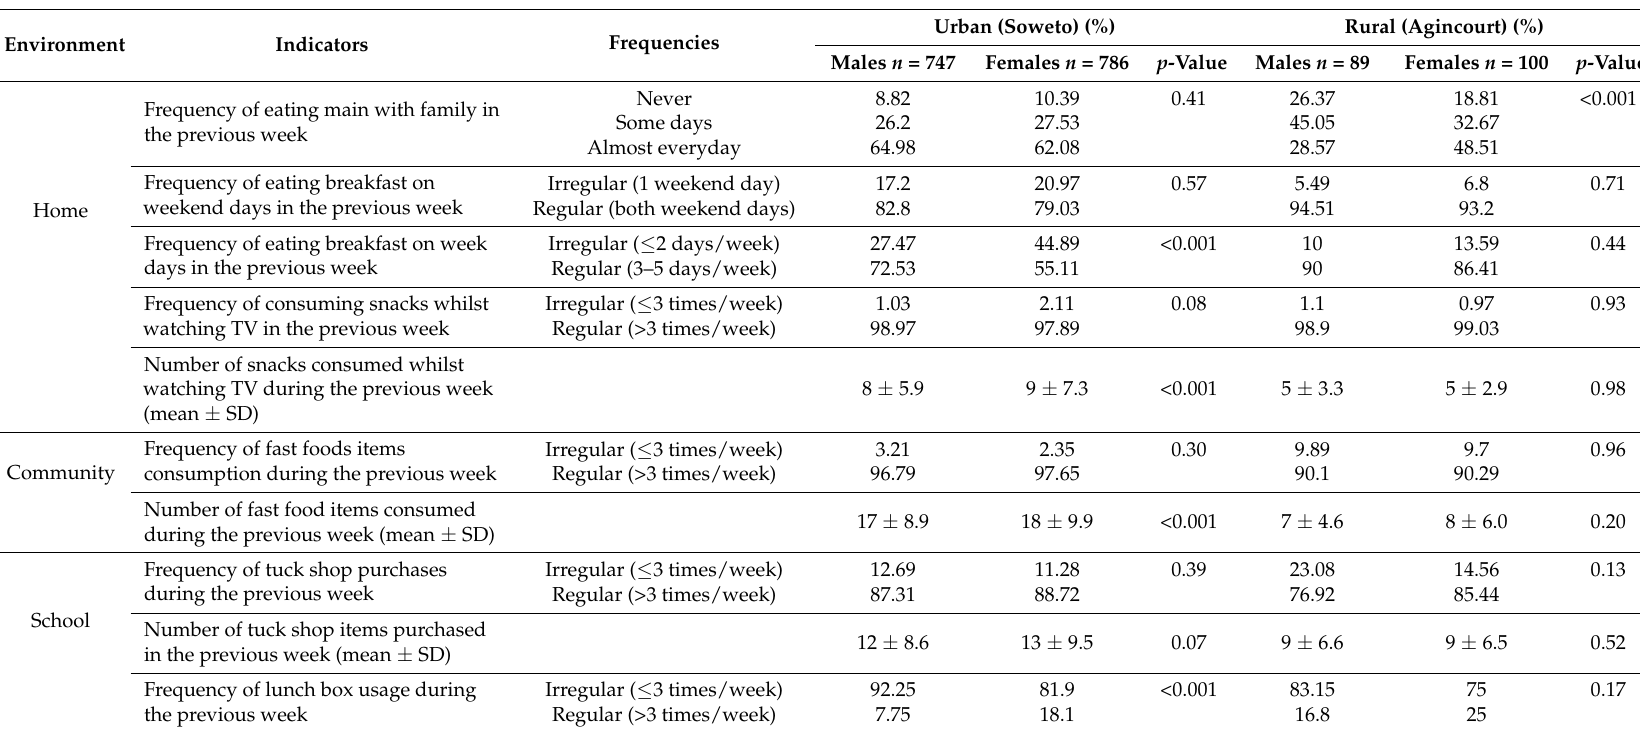
Table 3. Comparison of dietary practices and eating habits between genders within the same site in the Y15/MA group.